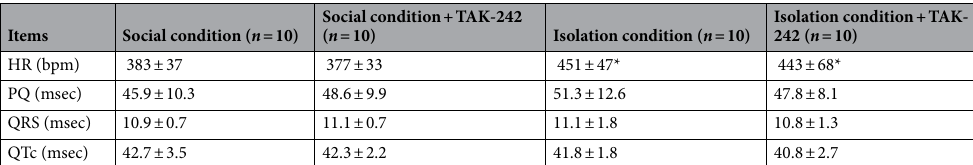
Items Social condition ( n = 10)